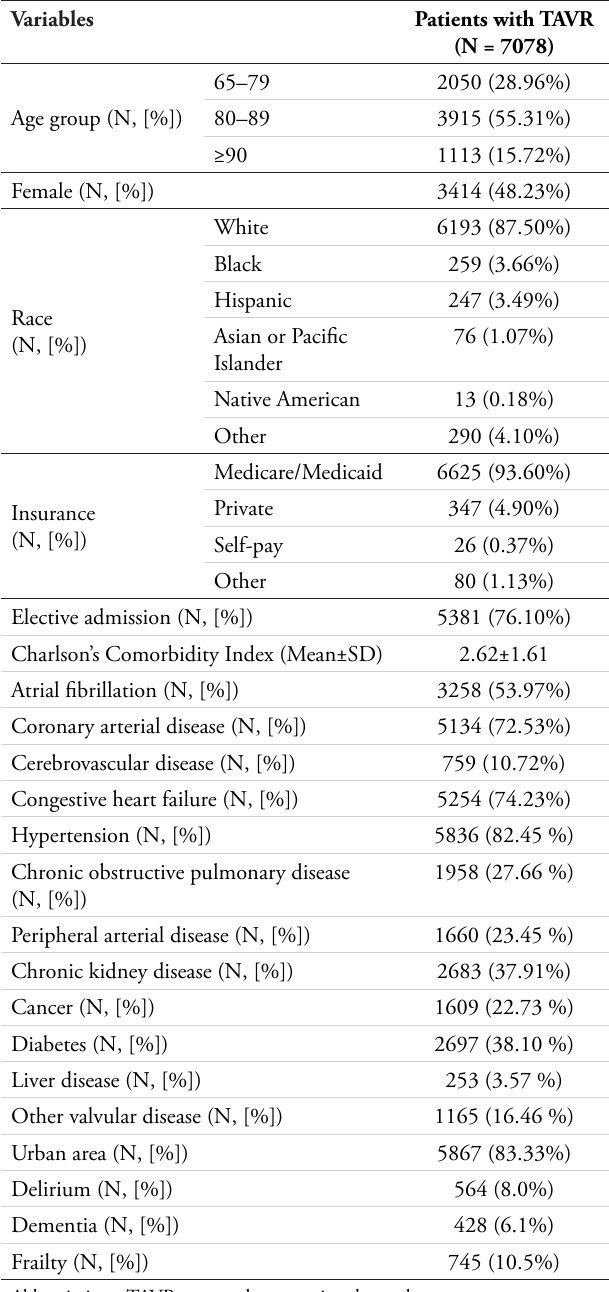
Table 1. Baseline Characteristics of the Patients who Underwent TAVR from 2011 to 2014